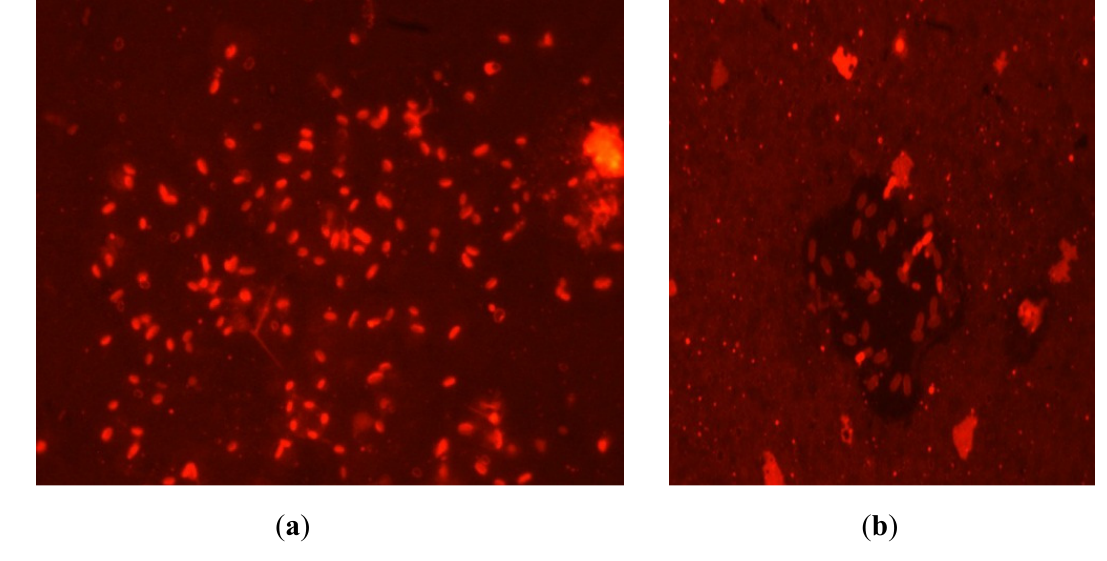
Figure 6. Free-living bacteria (dark objects) collected from the water column after 3 days. Flagella can be observed attached to the rod-shaped bacteria (1,000× magnification, bright